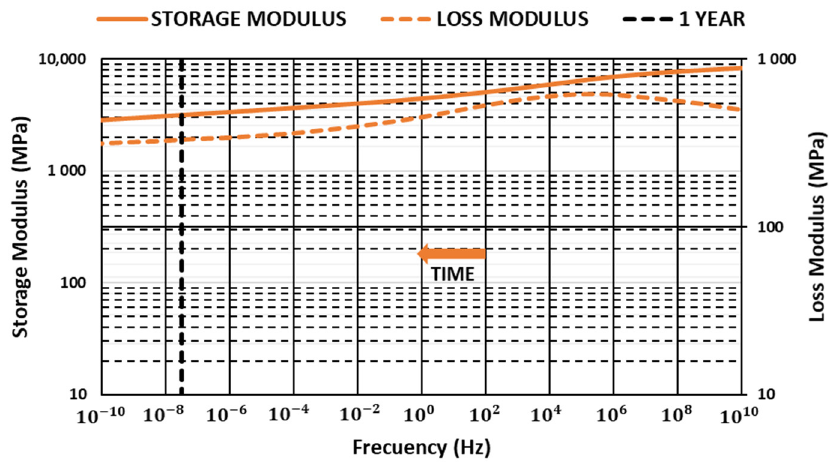
Figure 8. Variation in the storage and loss modulus with time PBT G50 (T = 64.4 °C).